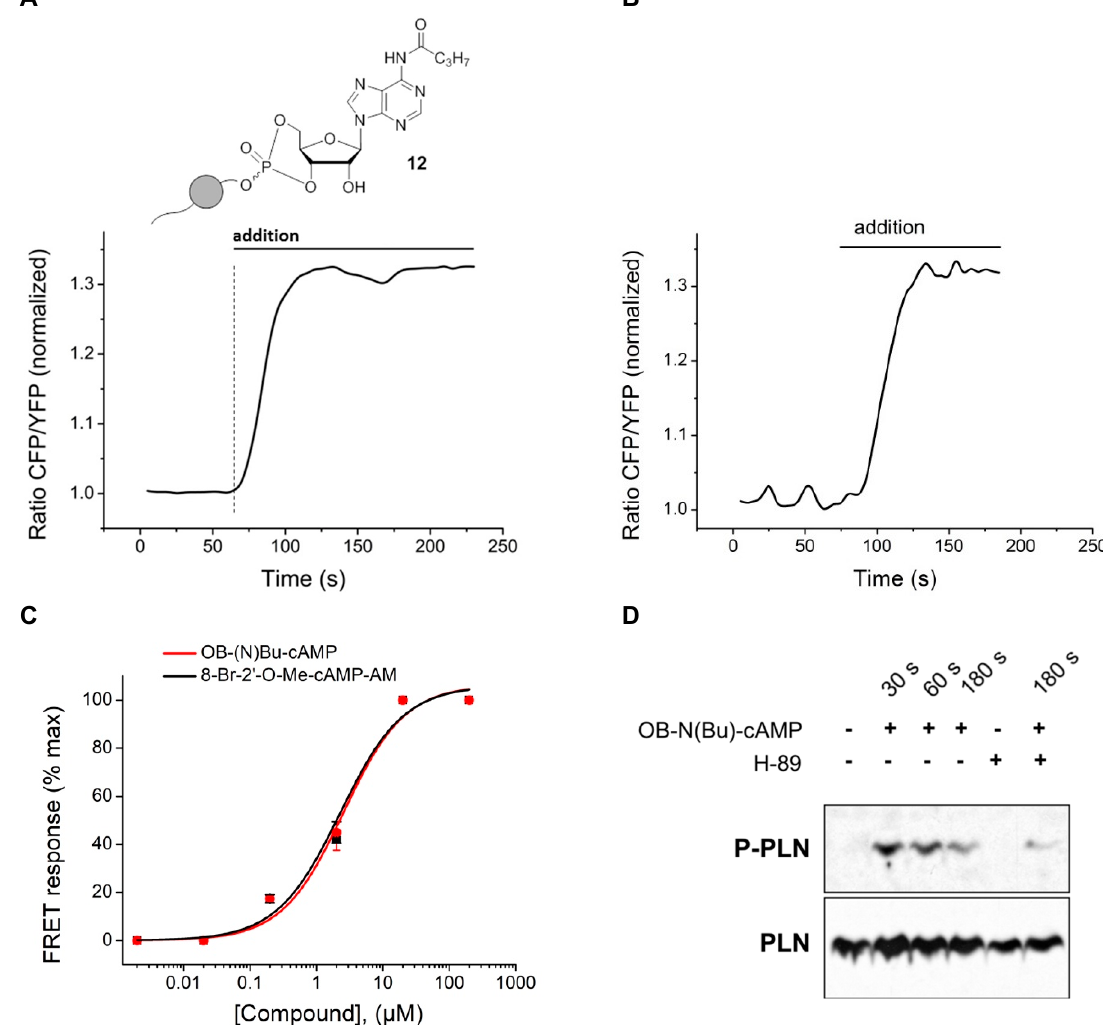
Figure 7. Normalized FRET ratio (between CFP and YFP) over the course of OB-N(Bu)-cAMP 12 addition (20 µM) in ( A ) or of 8-Br-2’-O-Me-cAMP-AM application (20 µM) in ( B ) to mouse cardiomyocytes expressing Epac1-camps biosensor for intracellular cAMP. An instantaneous increase of FRET ratio after addition of 12 to the extracellular medium indicated intracellular release of cAMP and its binding to the FRET biosensor. Representative experiments (n = 5). ( C ) concentration–response dependencies to both analogues show similar potencies (mean ± SEM, n = 5 for each point). ( D ) cardiomyocyte incubation with OB-N(Bu)-cAMP led to rapid phosphorylation of the cAMP dependent protein kinase substrate phospholamban (PLN). Cells were incubated for 30, 90, or 180 s with OB-N(Bu)-cAMP and lysed for immunoblot analysis. Alternatively, cells were preincubated for 20 min with 10 µM of the kinase inhibitor H-89 before 180 s treatment with OB-N(Bu)-cAMP. Representative immunoblots (n = 3).